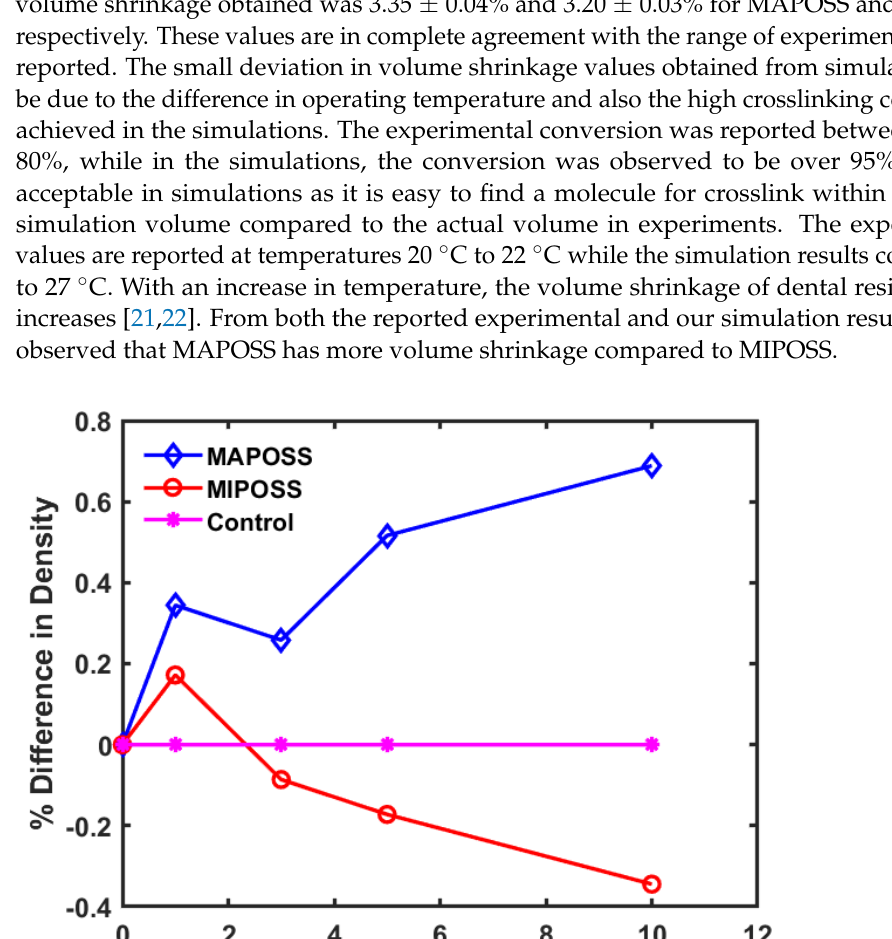
Figure 3. ( a ) Density vs. time profile; ( b ) cohesive energy vs. time profile for the Control.